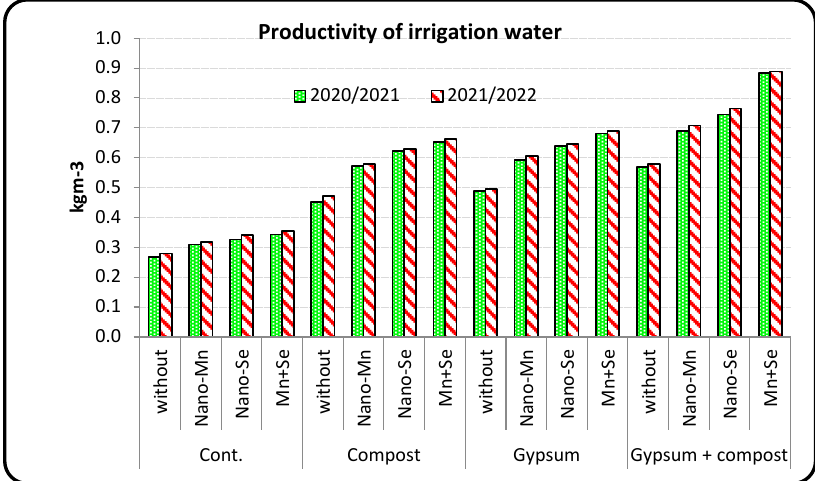
Figure 3. Effect of the application of soil amendments and foliar application of some nanoparticles on the productivity of irrigation water (PIW, kg seed m − 3 ) during the 2020/2021 and 2021/2022 growing seasons.